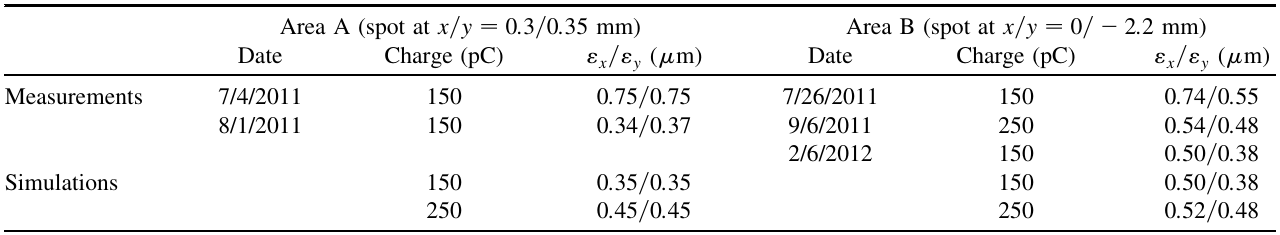
TABLE III. Summary of the emittance evolution following the laser